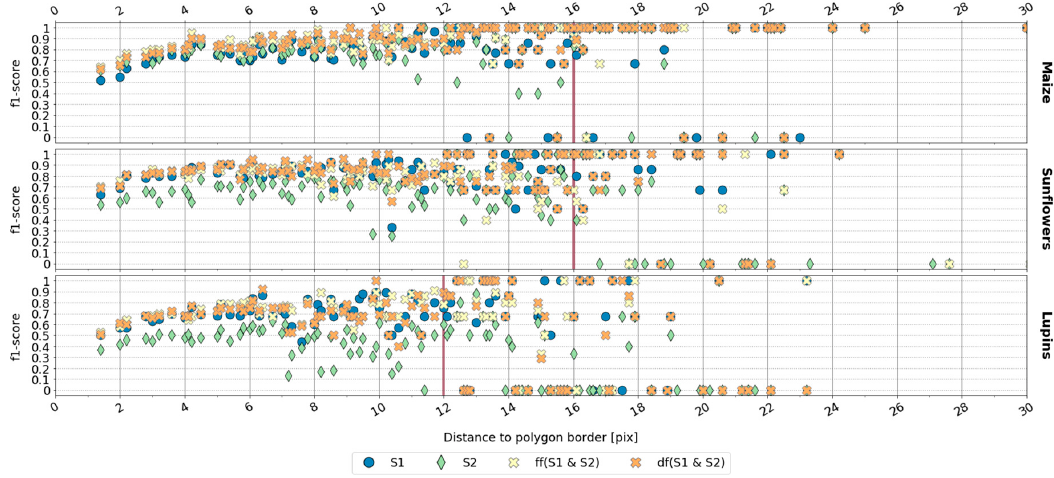
Figure 14. Variations in accuracy, depending on the distance of pixels to the parcel borders (y-axis). Vertical red lines indicate that 80% of the data lie on the left side of this axis.